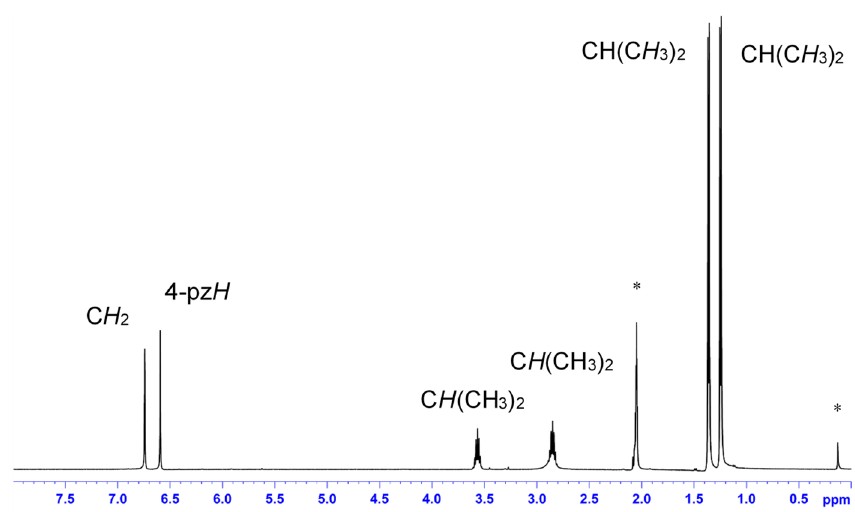
Figure 4. 1 H-NMR spectrum of [Co(NO) 2 (L1”)](BF 4 ) at room temperature in (CD 3 ) 2 CO (* marks solvent and TMS peaks).